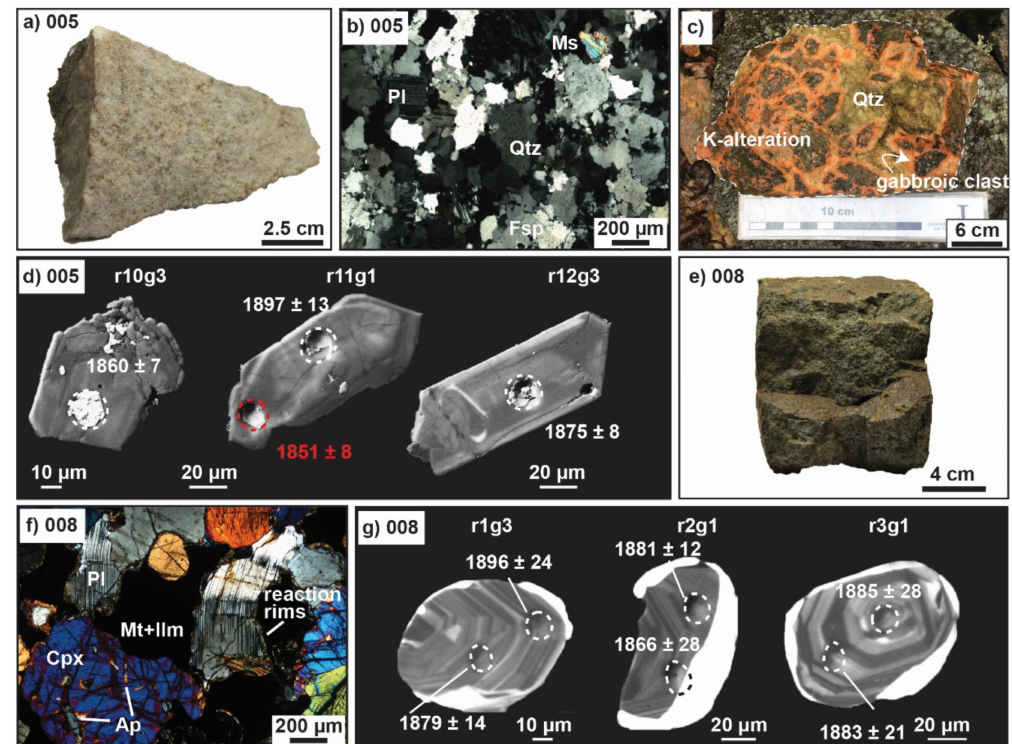
Figure 4. Sample images from the Kalixforsbron area. ( a ) Hand specimen for sample 005 showing fine-grained granitic texture. ( b ) Micrograph in cross-polarized light (XPL) of sample 005 with serrated and embayed grain boundaries between quartz, plagioclase, and feldspar. ( c ) Brecciated and potassic-altered gabbro with quartz infill in a deformation zone at the edge of the gabbroic pluton. ( d ) Cathodoluminescence images of typical zircon grains for sample 005. ( e ) Hand specimen of magnetite–ilmenite gabbro. ( f ) Micrograph of sample 008 magnetite–ilmenite gabbro in XPL with reaction coronas between plagioclase and magnetite–ilmenite. ( g ) Cathodoluminescence images of typical zircon grains for sample 008. In ( d , g ), dashed white and black circles highlight each concordant SIMS spot analysis while red circles and text are discordant. Ages reported are 207 Pb/ 206 Pb ± 2 σ .